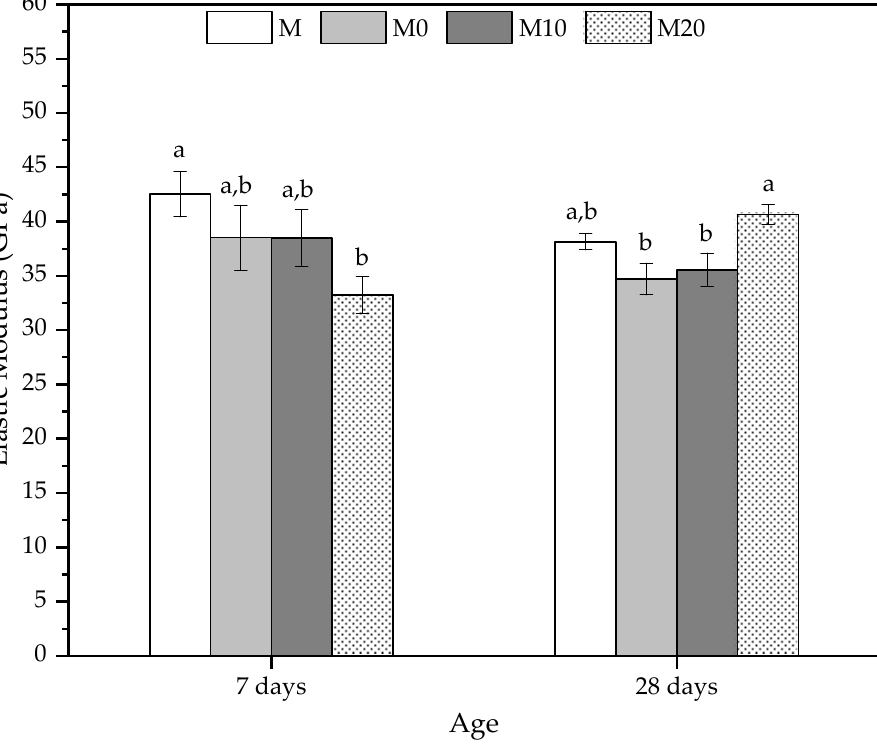
Figure 7. Elastic modulus at 7 and 28 days to mortars produced with 0, 10, and 20% Cloisite Na + nanoclay hydrogels. Average with their respective standard deviation values, followed by equal letters do not differ statistically from each other following the Tukey test with a 95% confidence level.